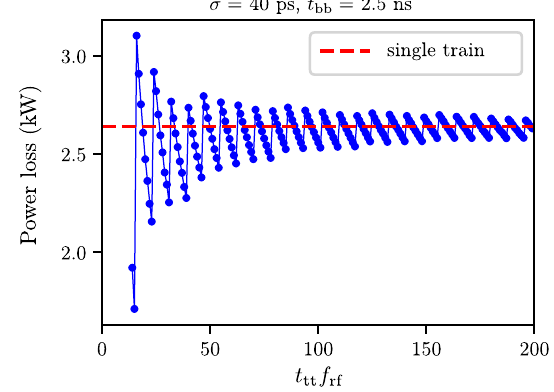
FIG. 13. Dependence of the power loss from continuous impedance spectrum on train spacing. The horizontal dashed line is the value for a single train. Calculations are done for parameters of the Z machine.